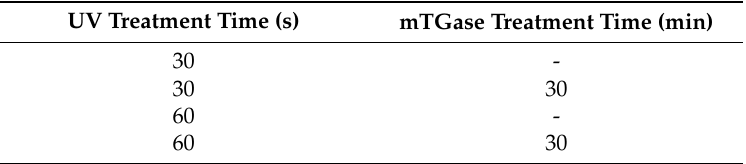
Table 1. Parameters used for gel